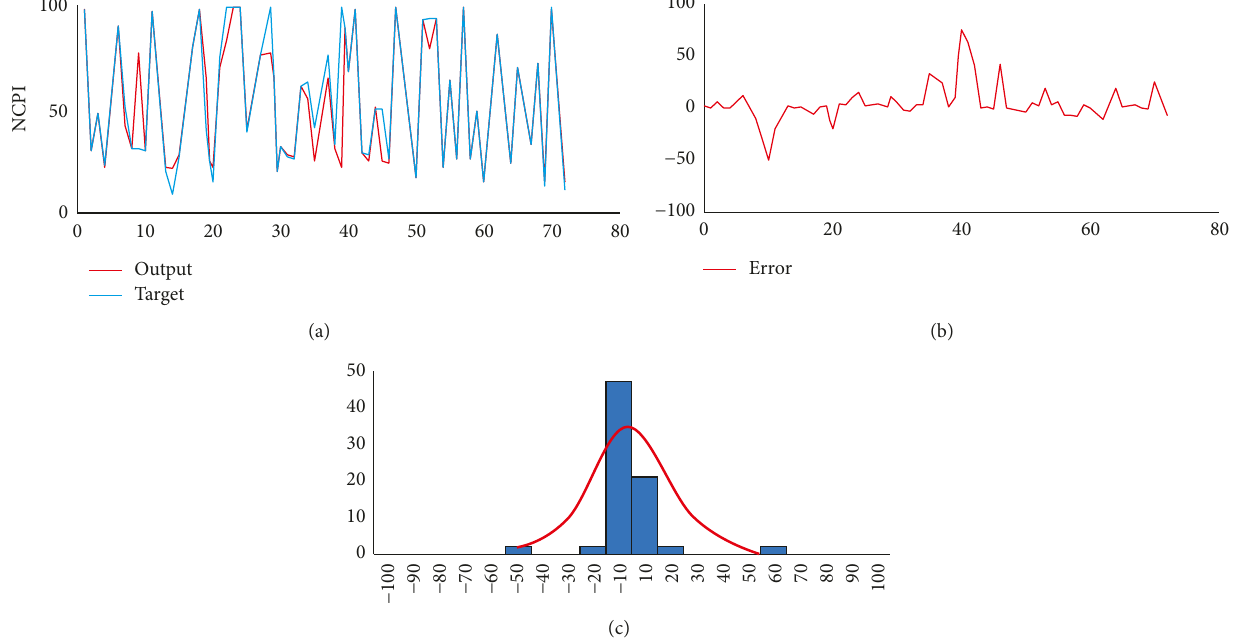
Figure 10: Ramps: (a) test data comparison of the ANN output and the NCPI in rows of information as target, (b) error diagram, and (c) error